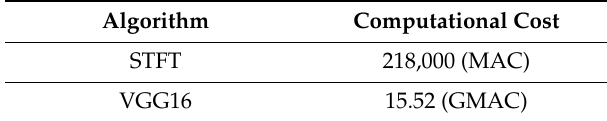
Table 5. Computational costs for Short-Time Fourier Transform (STFT) and VGG16.